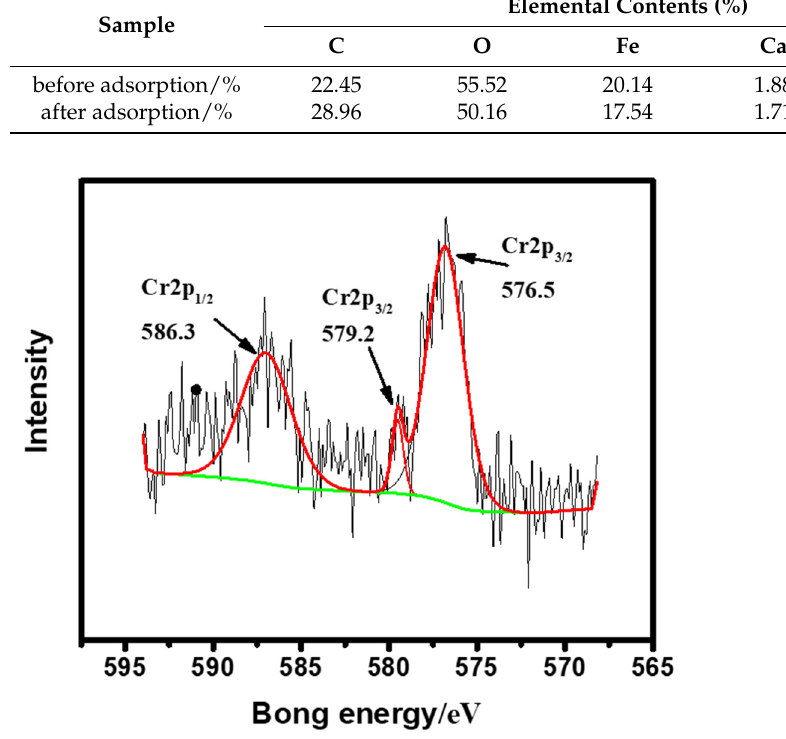
Figure 9. XPS patterns of SP@nZVI. The red and green lines are the fitted curve of raw data and the baseline, respectively.